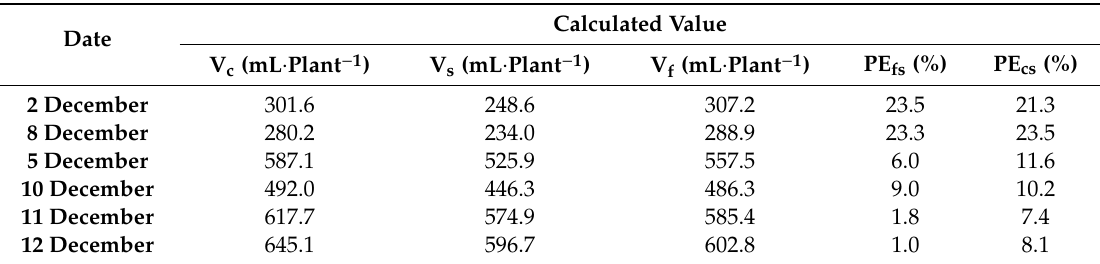
Table 2. Evaluation parameters of tomato water requirements calculated according to di ff erent estimation methods of H i under di ff erent